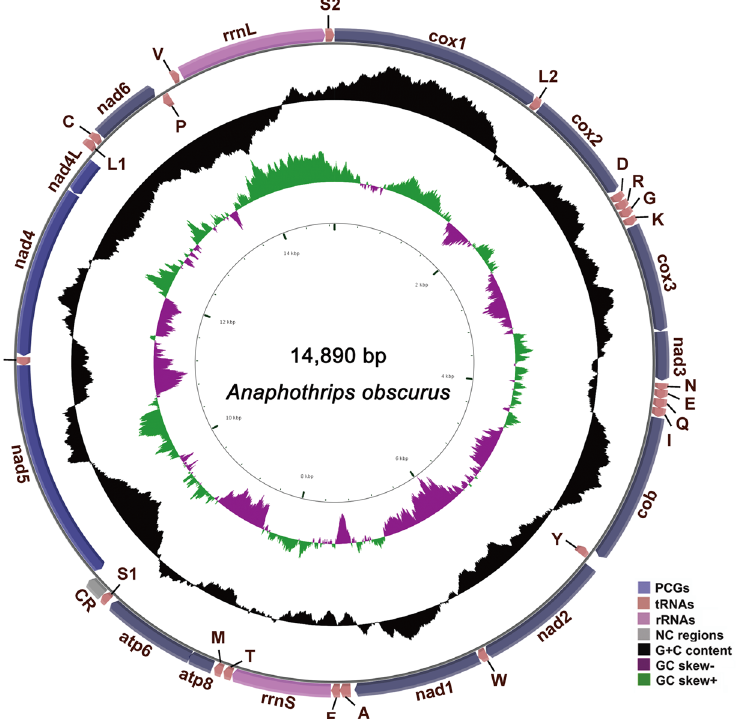
Figure 1. The mitochondrial genome of the grass thrips, Anaphothrips obscurus . Direction of gene transcription is indicated by arrows. Protein-coding genes are shown as dark blue arrows, rRNA genes as orchid arrows, tRNA genes as coral arrows and large NC regions ( > 100 bp) as grey rectangles. tRNAs are labeled according to their single-letter abbreviations. The GC content is plotted using a black sliding window, as the deviation from the average GC content of the entire sequence. GC-skew is plotted using a colored sliding window (green and orchid color), as the deviation from the average GC-skew of the entire sequence. In the very inner cycle, the nucleotide positions in the mitochondrial genome start from the 5 ′ -end of cox1